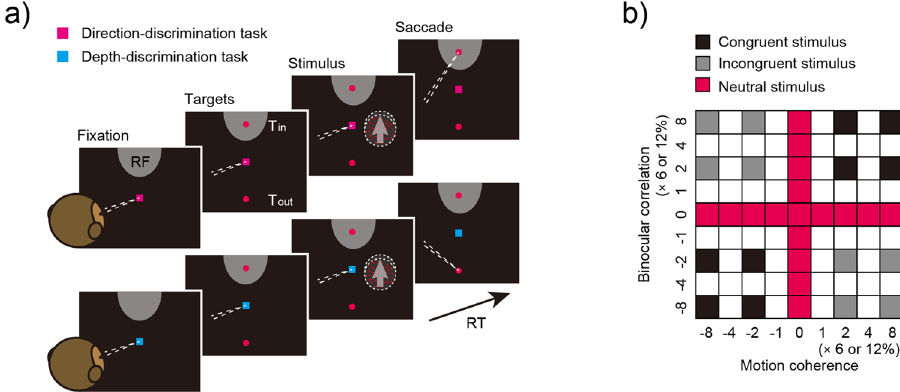
Fig. 1 The reaction time cued task-switching paradigm. a Reaction time cued task-switching paradigm. Monkeys performed a direction-discrimination task or depth-discrimination task according to the color of the fi xation point trial by trial. When the fi xation point color was magenta, the monkeys were required to report whether the dots moved upward or downward by making a saccade to the upper or lower targets, respectively (direction-discrimination task). When the fi xation point color was cyan, the monkeys were required to report whether the dots were farther or nearer than the plane of fi xation point by making a saccade to the upper or lower targets, respectively (depth-discrimination task). The monkeys were allowed to make a saccade at any time to report motion direction or stereoscopic depth of the visual stimulus. Tin refers to the saccade target that corresponds to either the response fi eld of the LIP neuron or the preferred direction of the MT neuron. Tout is located diametrically opposite. RF: response fi eld of LIP neuron, RT: reaction time. b Stimulus conditions used in the experiments. Filled stimulus conditions were used in this experiment. Black- and gray-colored squares denote stimulus conditions where both motion coherence and binocular correlation were non zero. The correct choice was the same for both tasks for congruent stimuli (black-colored squares), whereas the correct choice was different depending on task for incongruent stimuli (gray-colored squares). Red-colored squares denote stimulus conditions where motion coherence and/or binocular correlation was zero, and thus the stimuli were neutral. Positive motion coherences and binocular correlations refer to motion direction and depth corresponding to the Tin target, and negative motion coherences and binocular correlations to those corresponding to the Tout